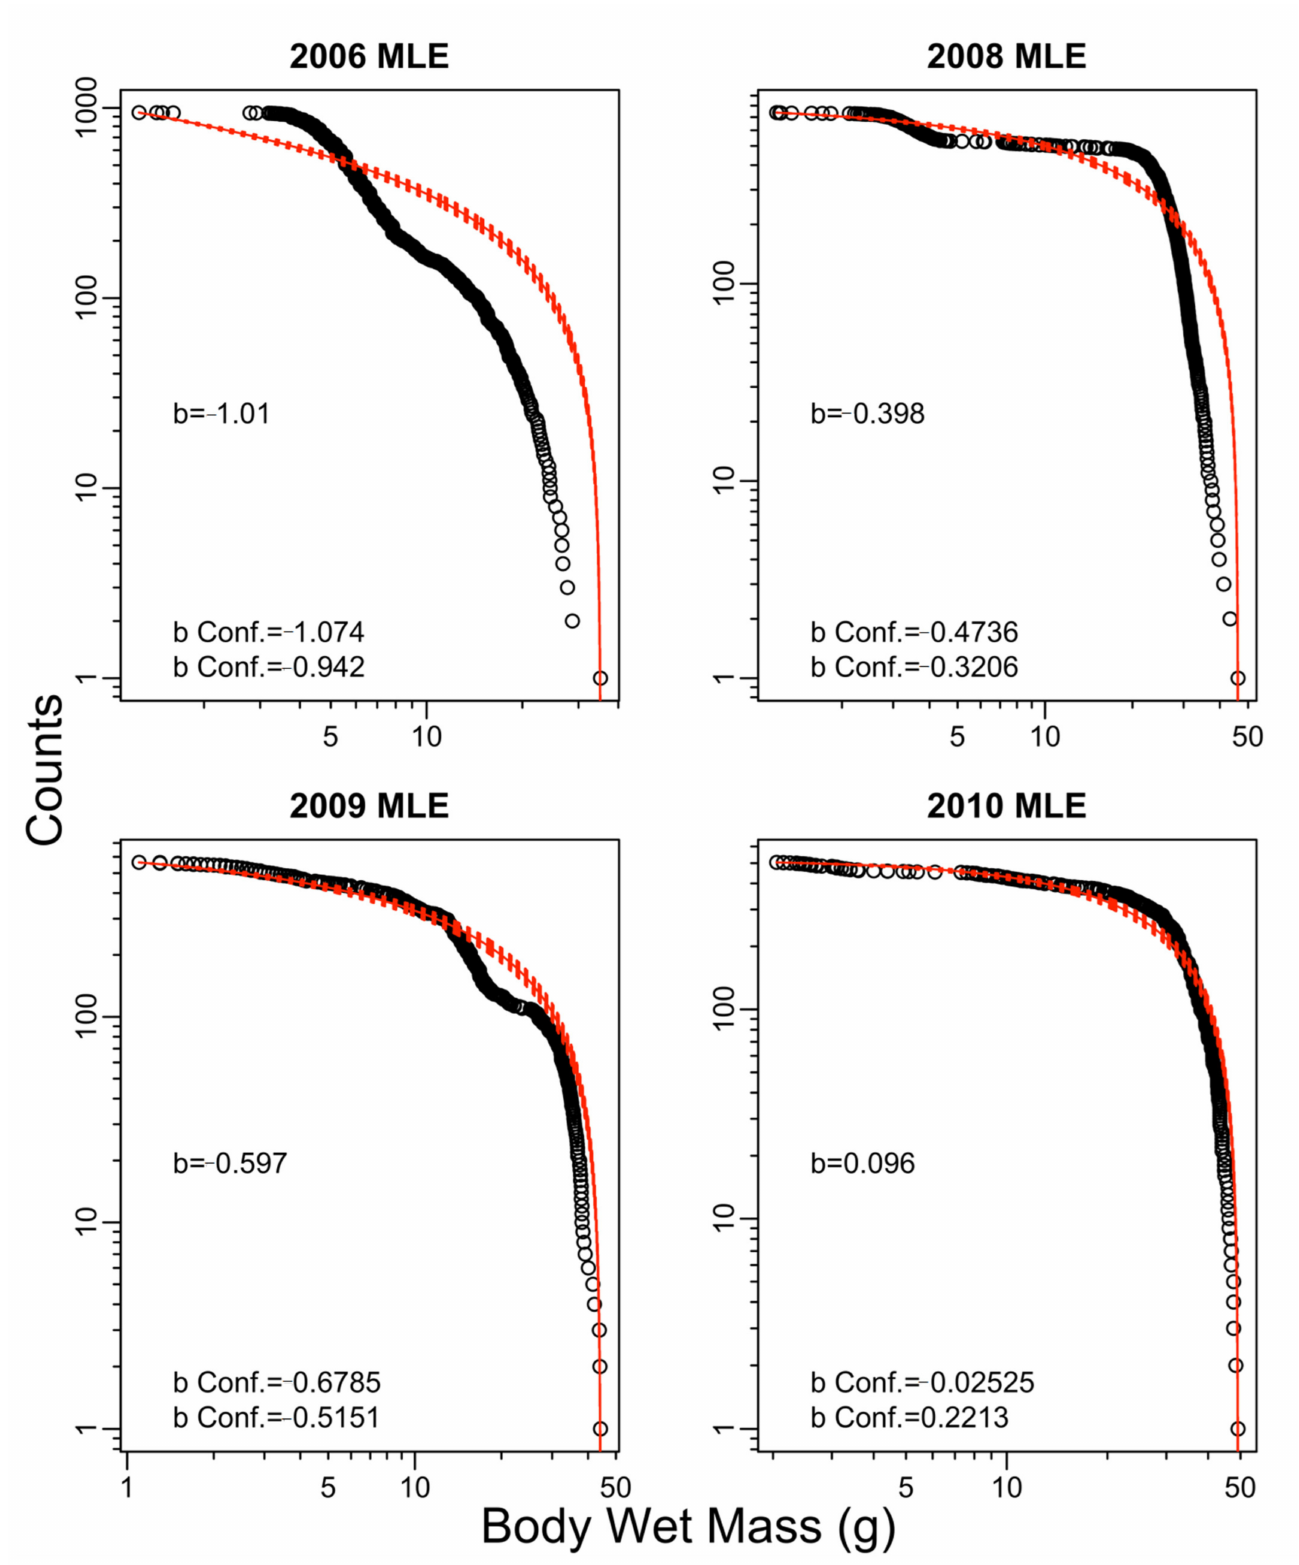
Figure A1. Fish SS with counts and body wet mass (g) fitted using the maximum likelihood estimate of exponent b with the 95% confidence interval of b based on trawling surveys for